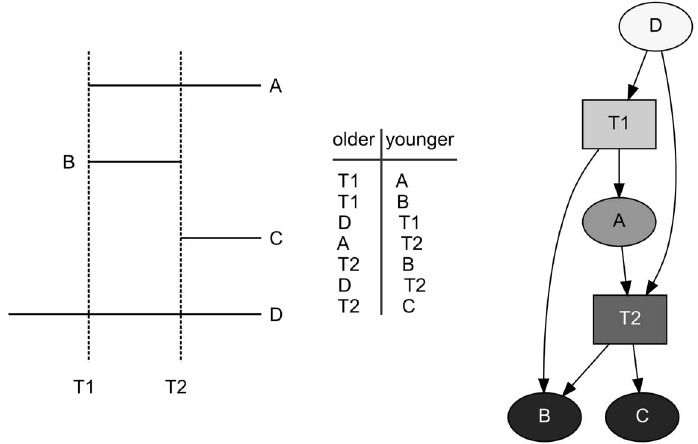
Figure 5. Level assignments. Left , map showing trails T1 and T2 with agricultural walls A , B , C , and D ; middle , table of the chronological relationships shown in the map; right , picture of a directed graph of the chronological relations, where ovals represent agricultural walls, rectangles represent trails, and arcs point from an older feature to a younger one. Symbols in the directed graph are shaded by relative age; older features are lighter-colored than younger ones.